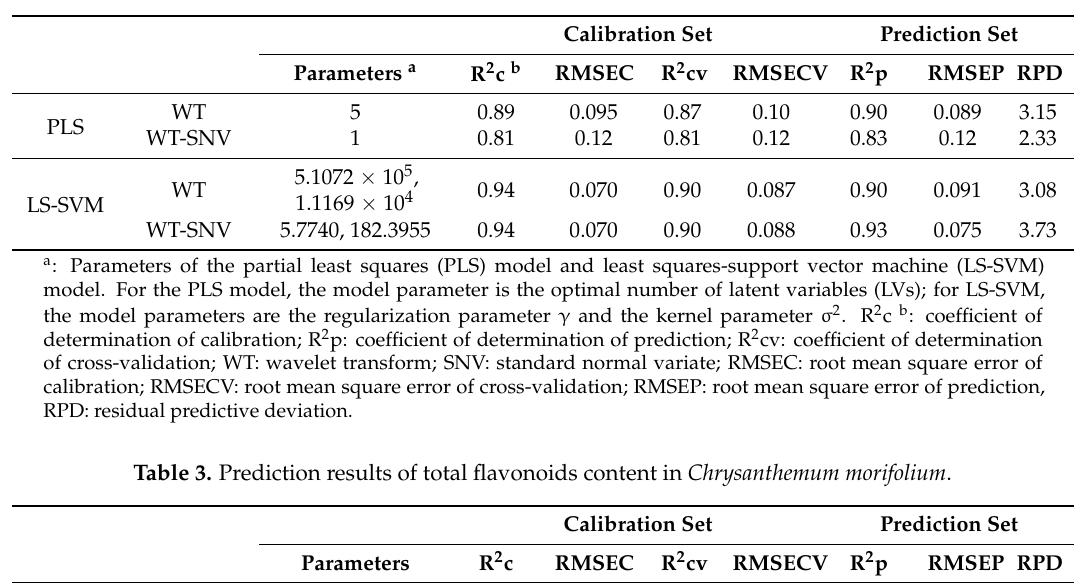
Table 2. Prediction results of total polysaccharides content in Chrysanthemum morifolium .